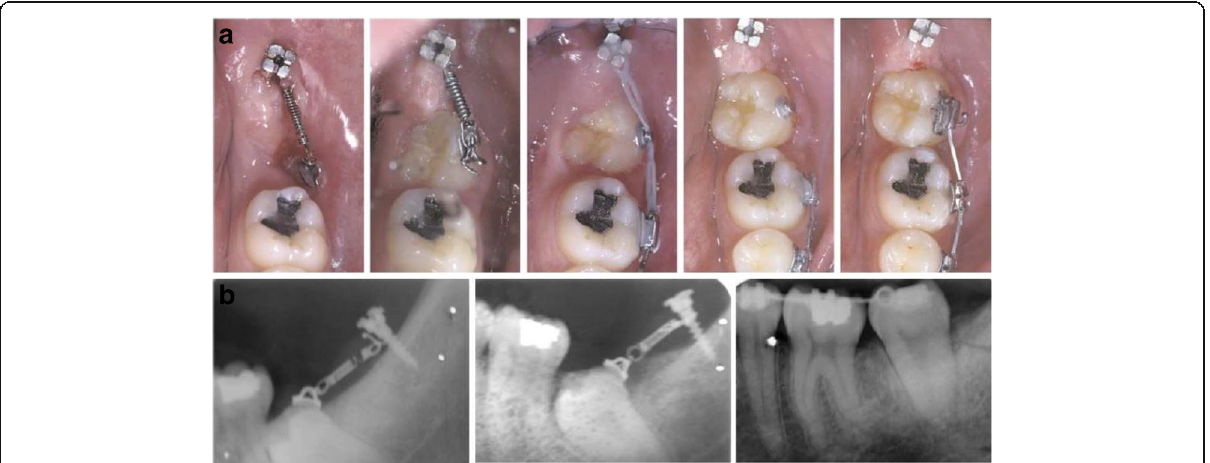
Fig. 6 Uprighting of an impacted #37 with miniscrew implant and a closed coil spring tied to an orthodontic bracket. a A 7-mm titanium miniscrew inserted in the retromolar area and loaded with 50-g force on nickel-titanium closed coil spring. After the extrusion of the crown, the tooth was uprighted with fixed sectional appliance. b Progress radiographs during the treatment (from Giancotti et al. [3], with kind permission of American Journal of Orthodontics and Dentofacial Orthopedics)